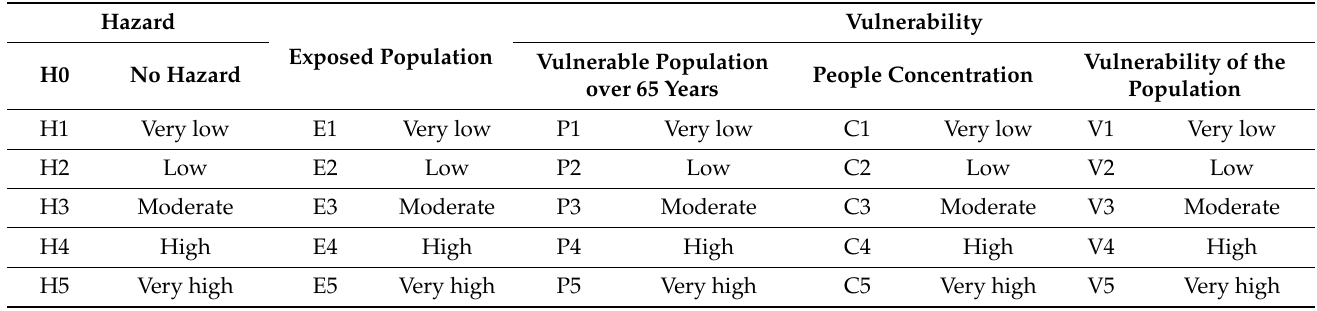
Table 2. Alphanumeric codes of the variables involved in the risk